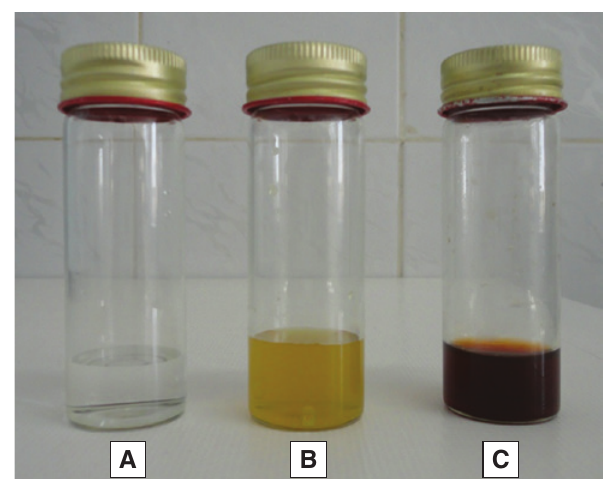
solution (A), Pelar- 3